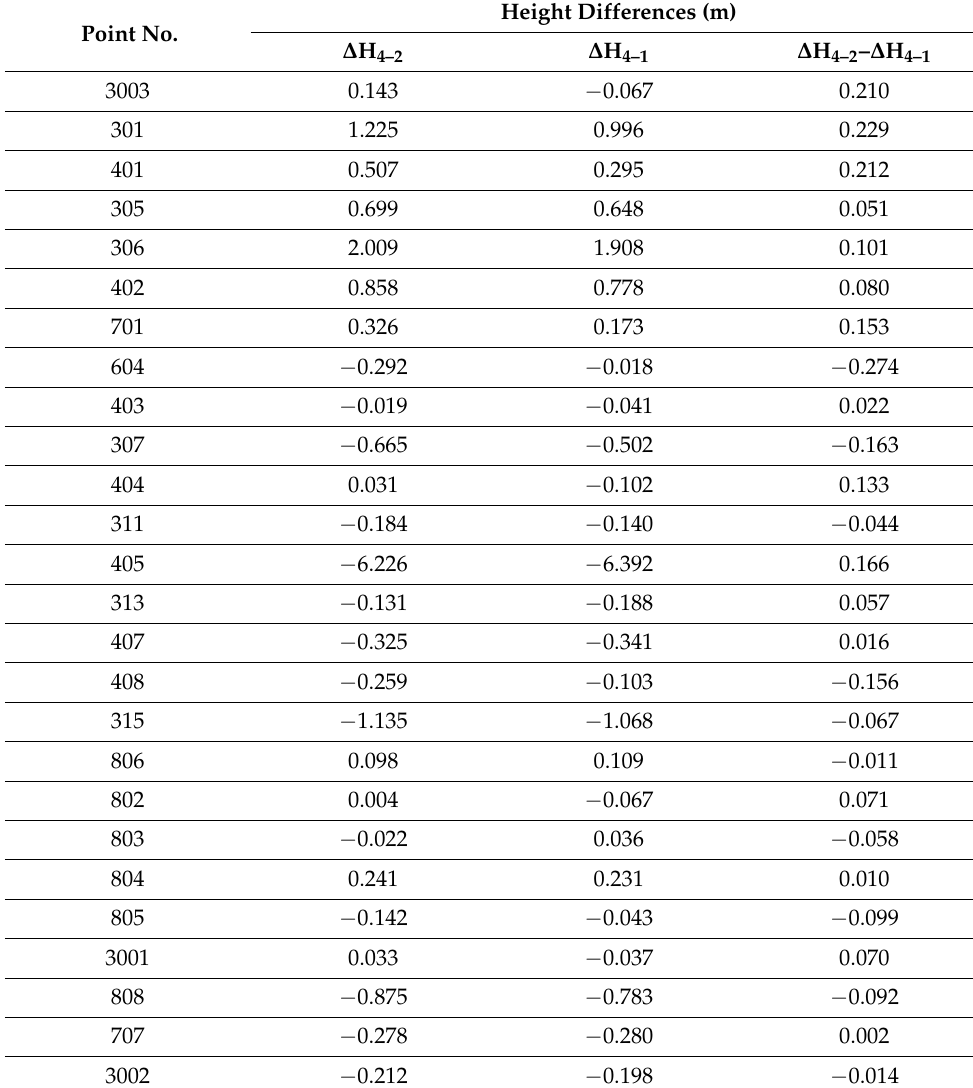
Table 1. Summary of height differences at the control points. Point